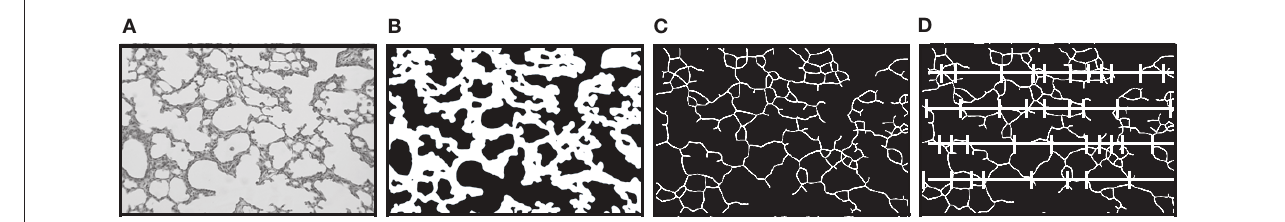
reduced to a skeletonized structure one pixel in width. (D) A series of probe lines are superimposed on the skeletonized image and points where the alveolar structure intercepts the probes are recorded and exported. Mean linear intercept equal total probe length divided by number of